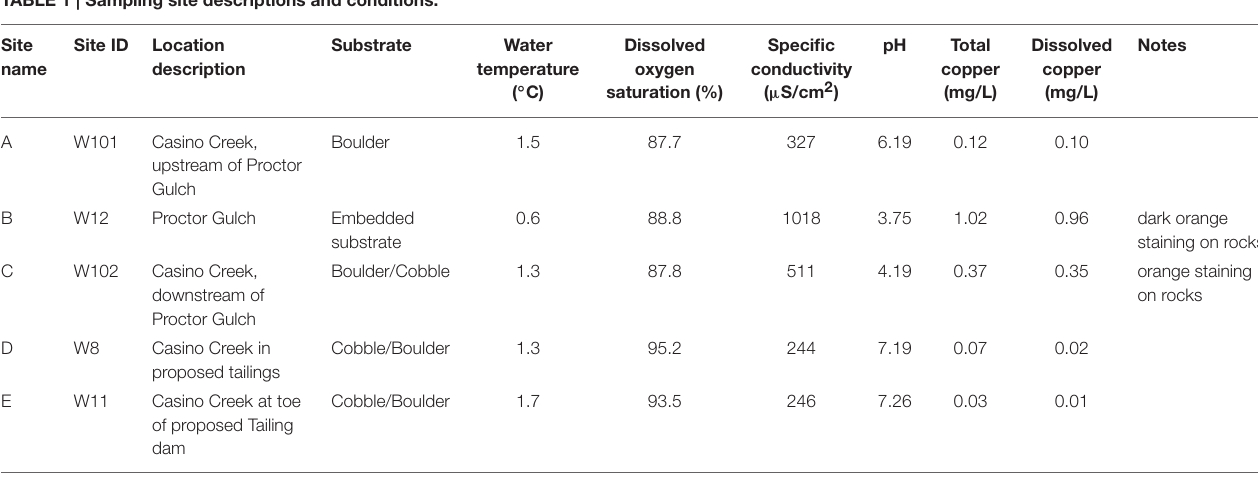
TABLE 1 | Sampling site descriptions and